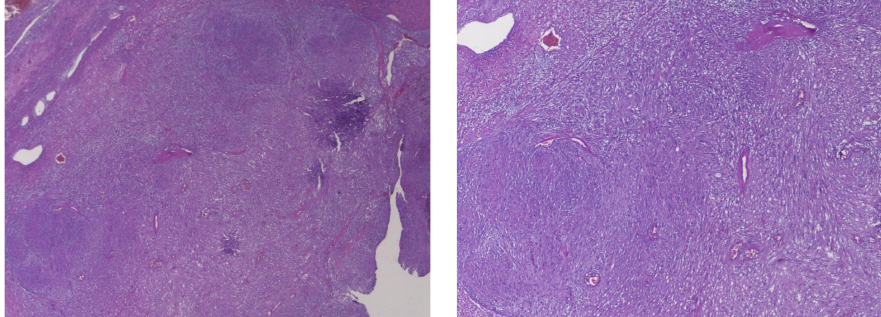
Figure 2: At microscopic examination, the tumor showed characteristic Antoni A and Antoni B